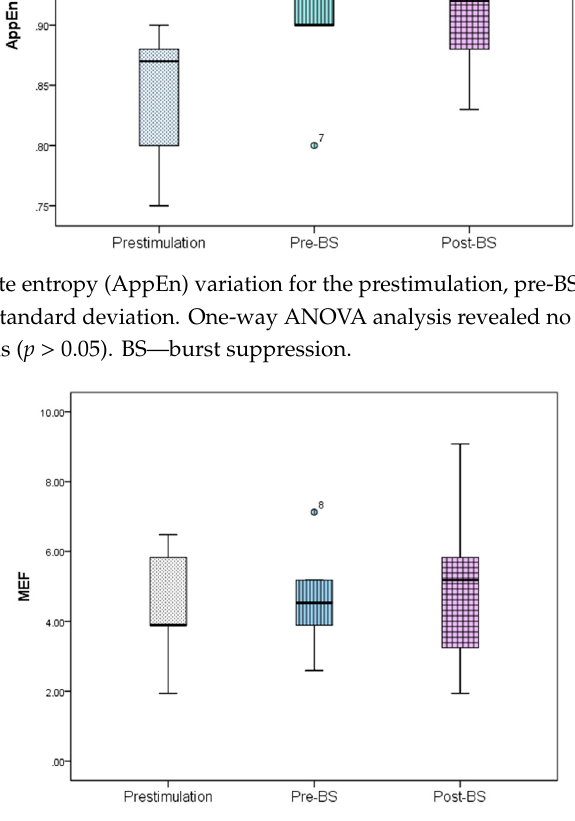
Figure 7. Spectral edge frequency (SEF) variation for the prestimulation, pre-BS period, and post-BS period. Error bars represent standard deviation. One-way ANOVA analysis revealed no statistical significance between these periods ( p > 0.05). BS—burst suppression.